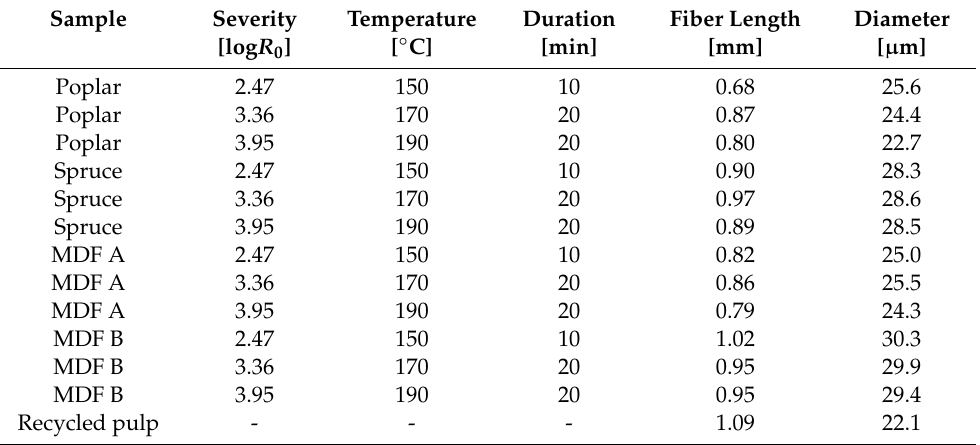
Table 4. Fiber length and diameter of steam-treated poplar, spruce, MDF A, MDF B, and recycled